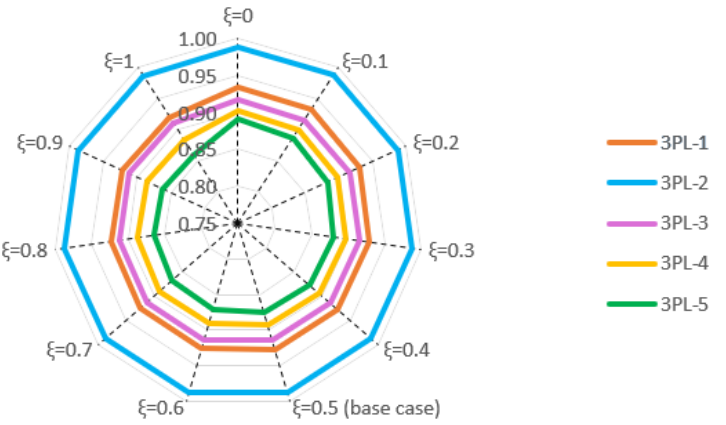
Figure 4. The sensitivity analysis to changes in the trade-off parameter ξ (Source: Authors).